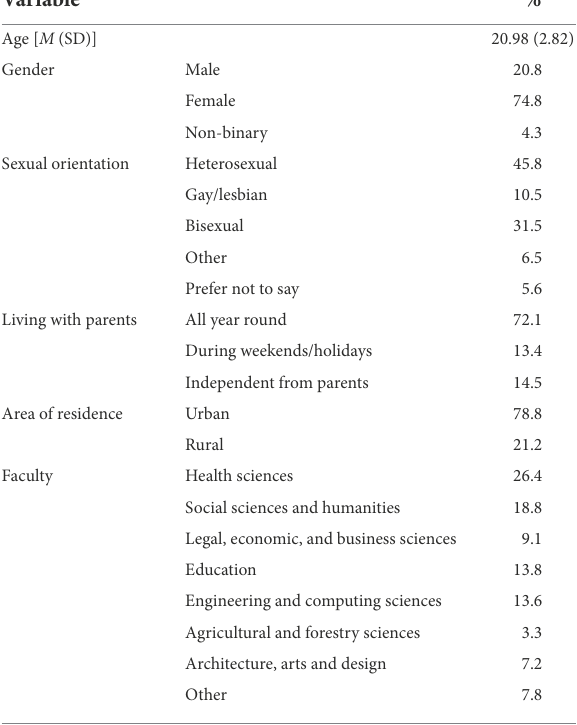
TABLE 1 Sociodemographic characteristics of the